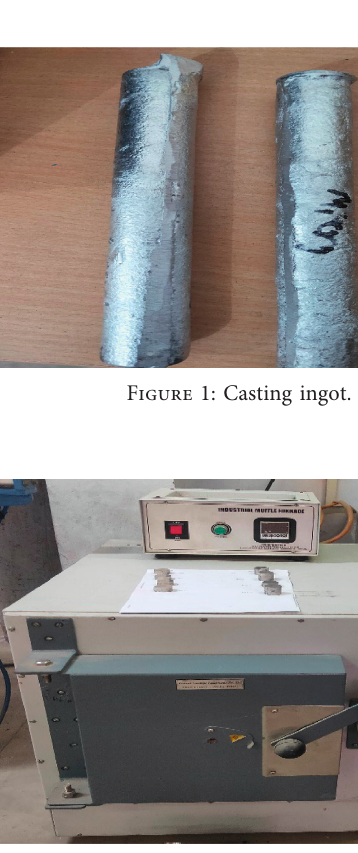
Figure 2: Industrial muffle furnace setup.